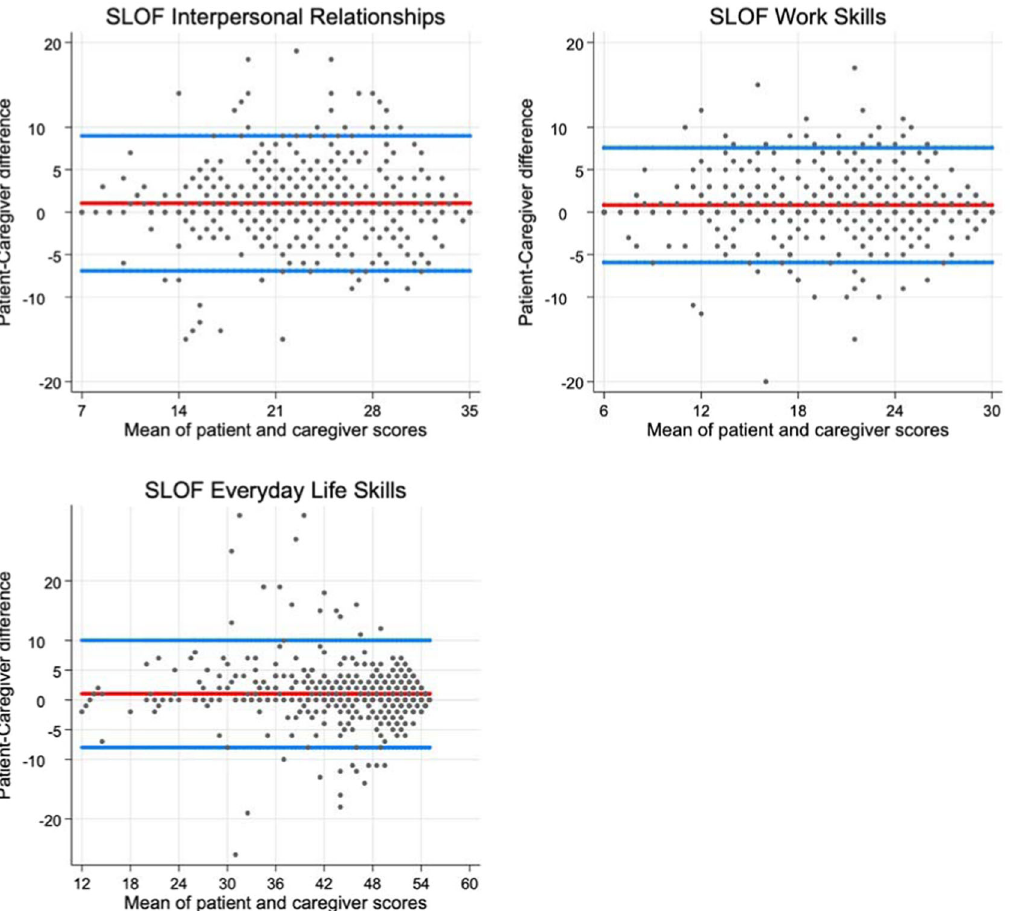
Fig. 1 Bland – Altman plots of patient-caregiver agreement on SLOF domains. Note: in these Bland – Altman plots circles represent patients; the upper and lower blue lines represent the 95% limits of agreement; the red line represents the average discrepancy between patients and caregivers. Cases lying between the blue lines are those whose patient and caregiver scores were with 95% probability concordant; those lying over the upper blue line are those whose self-reported functioning score was signi fi cantly higher than the corresponding score attributed by the caregiver; cases lying below the upper blue line are those whose self-reported functioning score was signi fi cantly lower than the corresponding score attributed by the caregiver. In the x axes, the mean of patient and caregiver scores is assumed as the more likely value of patient ’ s